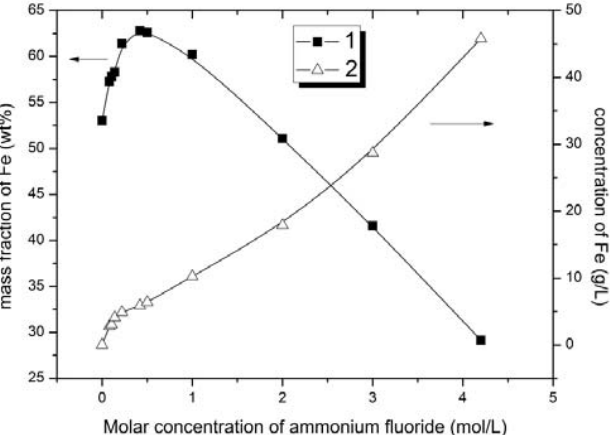
Figure 3. Iron content in the solid and liquid phases vs. concentration of ammonium fluoride. (1)—Mass fraction of Fe in solid phase (wt %); (2)—Concentration of Fe in liquid phase